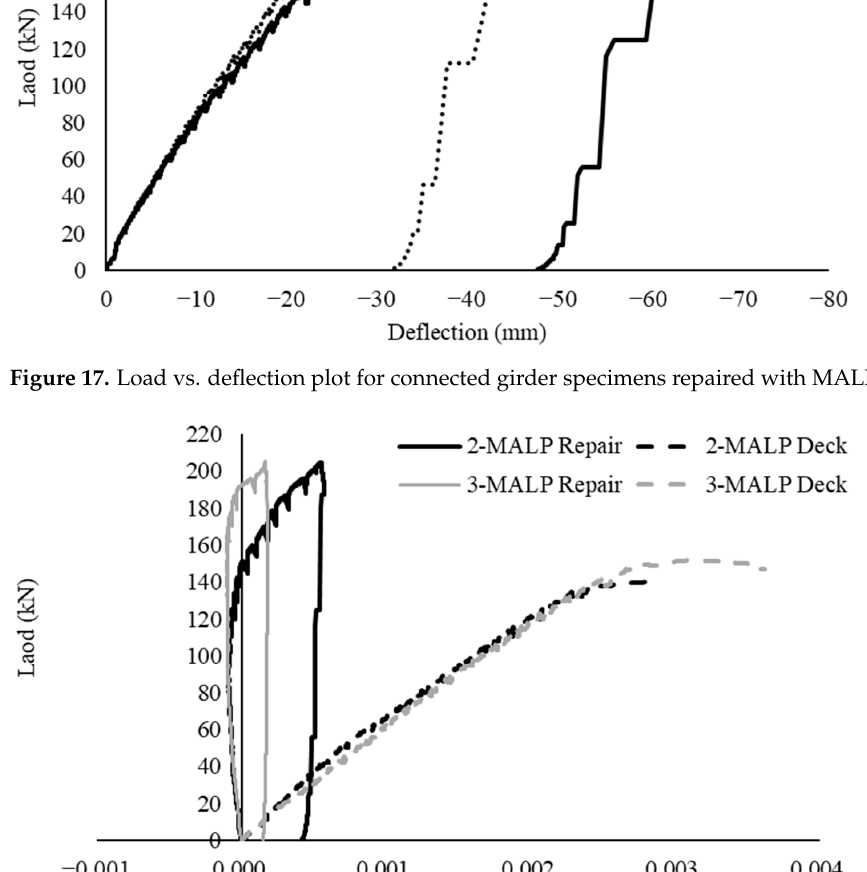
Figure 18. Load vs. strain plot for connected girder specimens repaired with MALP.